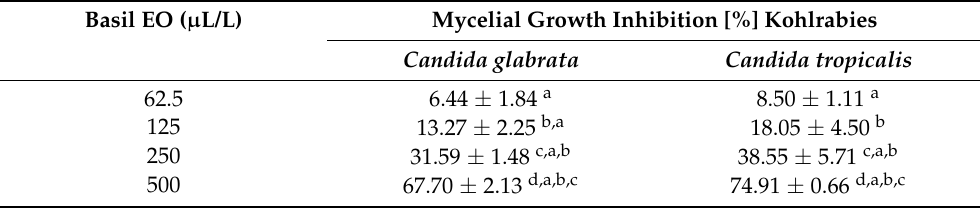
Table 11. In situ analysis of the anti-yeast activity of the vapor phase of OBEO on